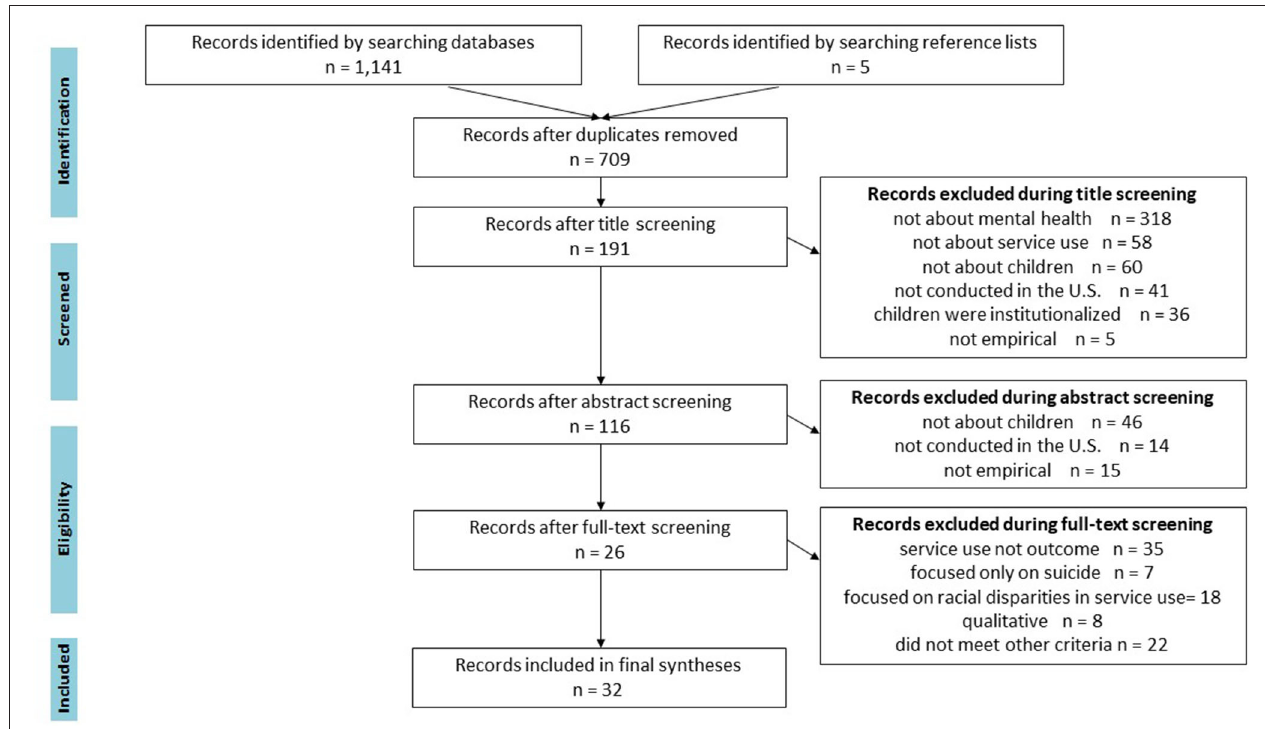
FIGURE 1 | PRISMA flow